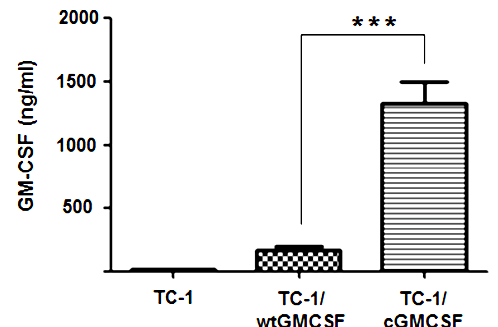
Figure 1. Increased levels of granulocyte-macrophage colony-stimulating factor (GM-CSF) production by TC-1 cells containing codon-modified GM-CSF. The level of GM-CSF production was quantified by performing ELISA. The results shown are representative of three independent experiments. *** p < 0.001; single classification ANOVA. wtGM-CSF: wild-type GM-CSF; cGM-CSF: codon-modified GM-CSF.